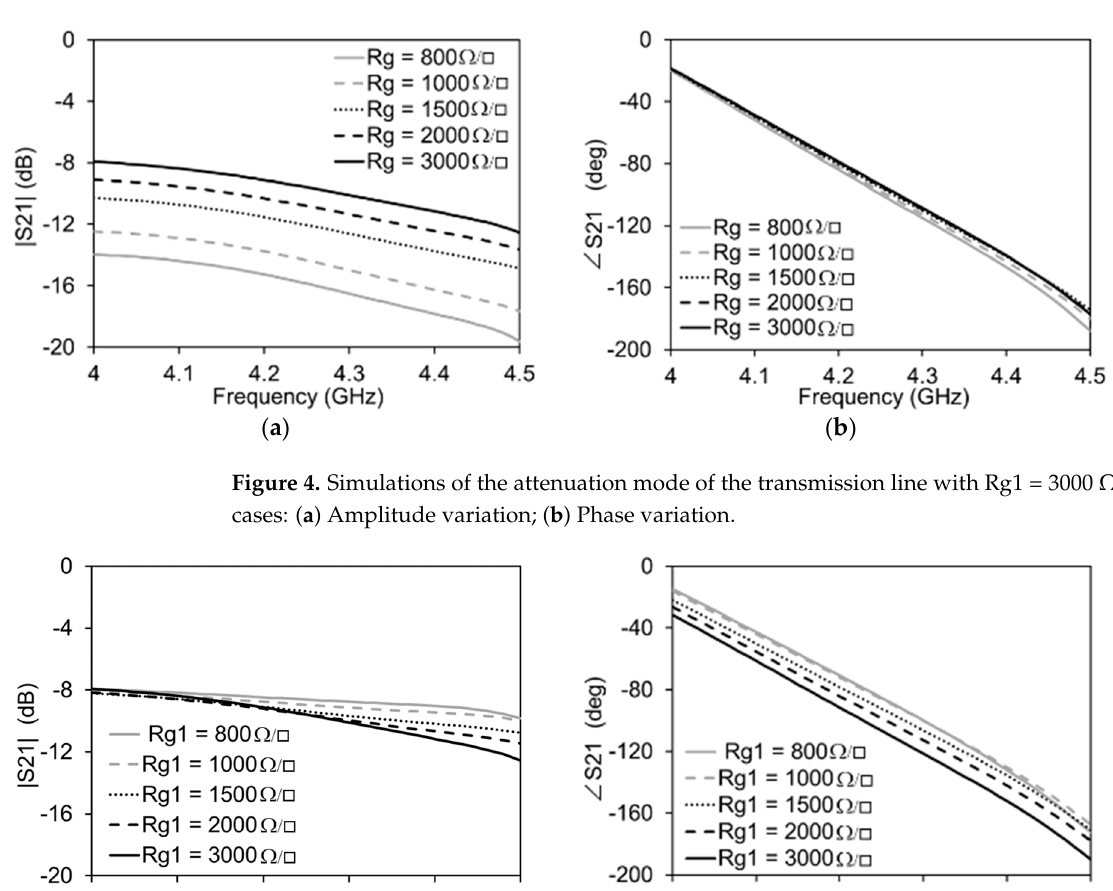
Figure 4. Simulations of the attenuation mode of the transmission line with Rg1 = 3000 Ω / for all cases: ( a ) Amplitude variation; ( b ) Phase variation.